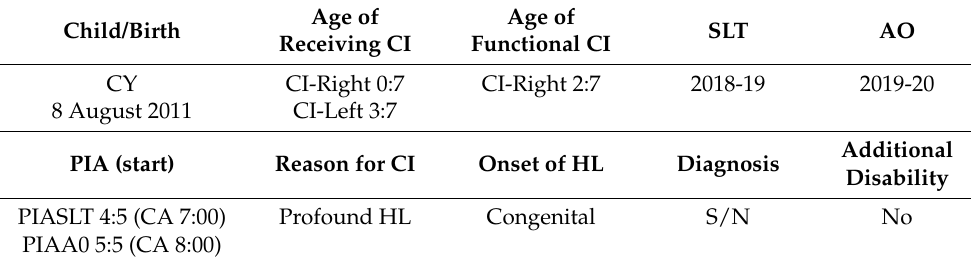
Table 1. Characteristics of the single-case study involved in this